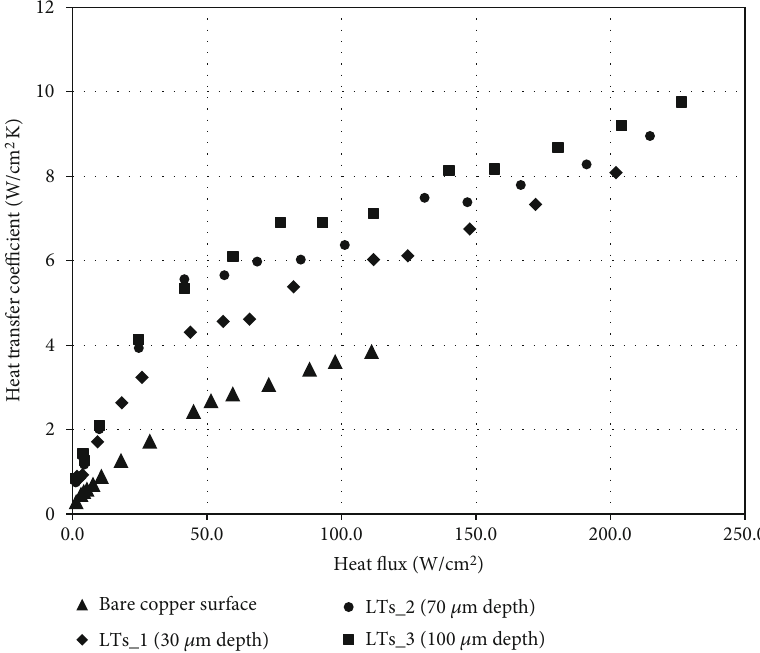
Figure 6: Heat transfer coe ffi cient variation concerning with heat fl ux.